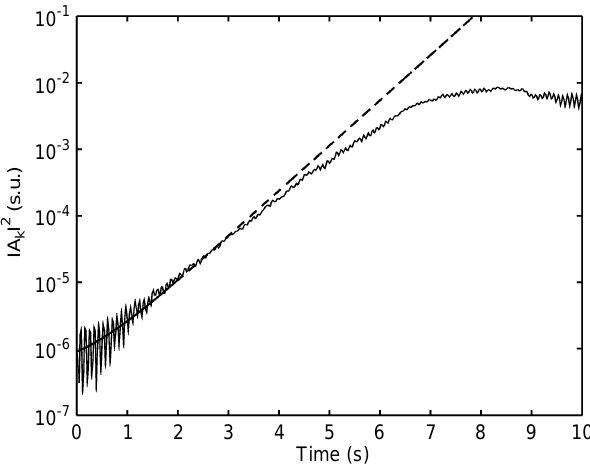
Fig. 4. The growth rate calculated form Eq. (5) ( dashed ), compared with the growth of the wave field in the simulation ( solid